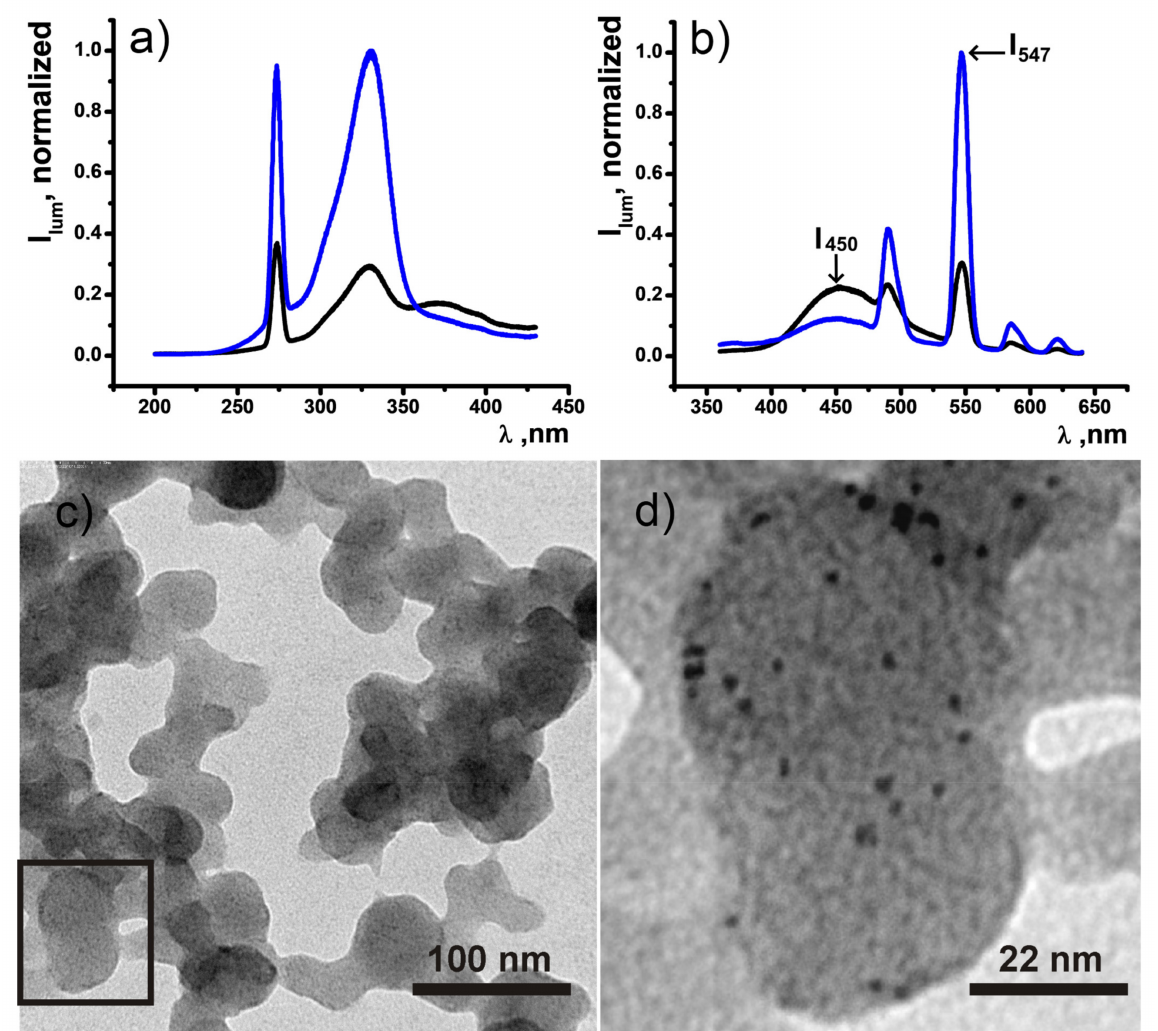
Figure 8. ( a ) Excitation spectra of PSS-{CDs-[TbL]} in H 2 O, ( λ em = 450 nm and 547 nm) ( b ) Emission spectra of PSS-{CDs- [TbL]} synthesized according to the Synthesis_1 and Synthesis_2 ( λ ex = 360 nm). ( c ) TEM image of dried PSS-{CDs-[TbL]} colloids. ( d ) Enlarged black rectangle area from the Figure